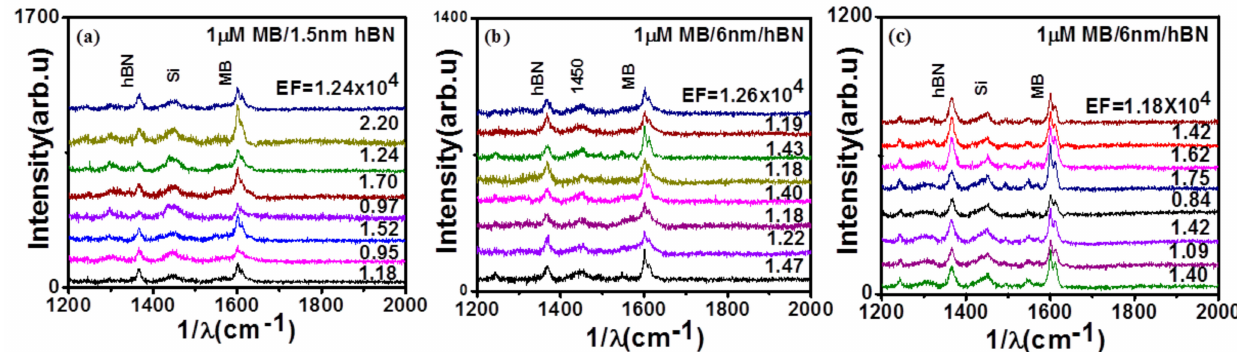
Figure 4. ( a , b ) Raman enhancement of 1 µ M MB by 1.5 and 6 nm film at different positions of the film. ( c ) Reproducibility studies—Raman enhancement of 1 µ M MB by a different 6 nm film at different